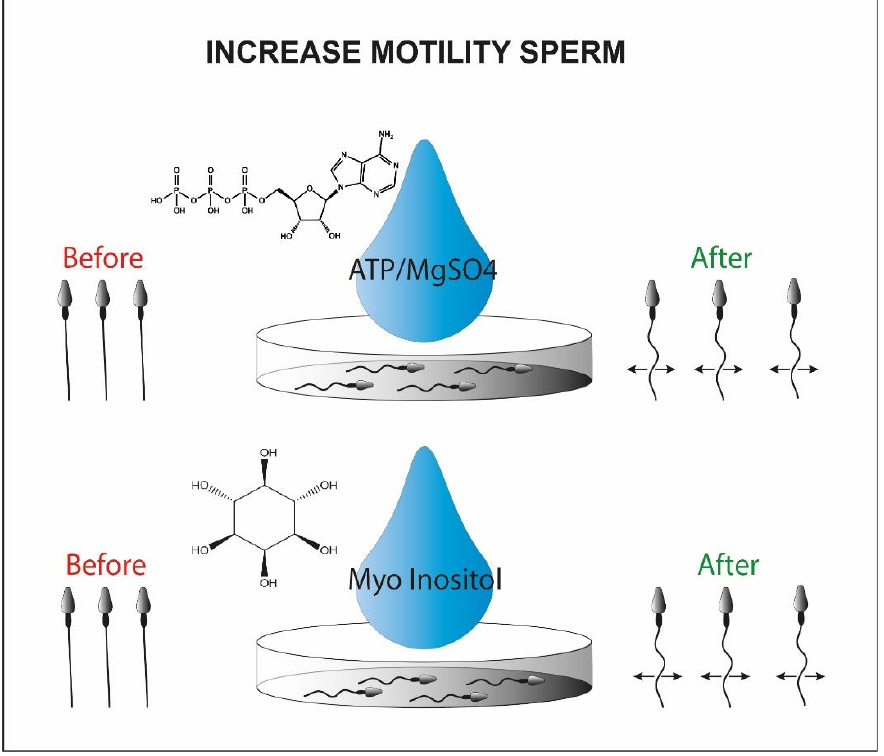
Figure 6. Sperm motility enhanced by ATP/MgSo4 or myo-inositol . Briefly in the picture we observe the immotile sperm before the treatment with the chemical inducer (left side) and the motile sperm cells after the chemical exposure (right side).